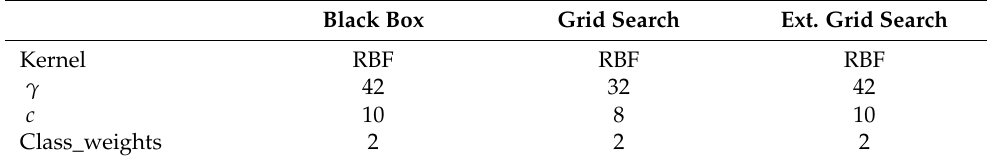
Table 4. Best hyperparameter configuration for SVM. Black Box Grid Search Ext. Grid